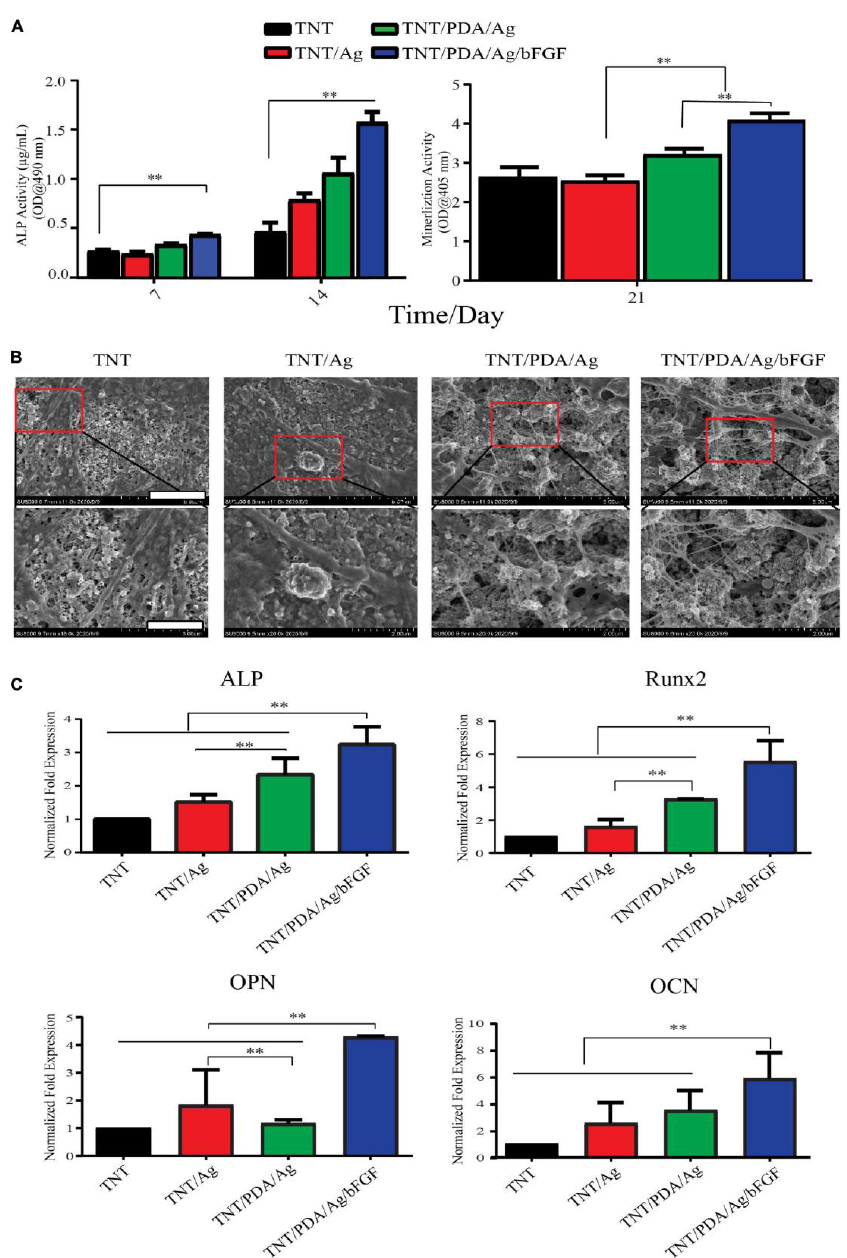
Figure 9. Growth factor-releasing nanotubular implants towards osseointegration. Enhanced osteogenic differentiation of dental pulp stem cells (DPSCs) on bFGF-loaded TNTs. ( A ) DPSCs showed significantly higher alkaline phosphate (ALP) activity; ( A , B ) more calcium deposition on bFGF-loaded TNTs, detected by Alizarin red staining ( A ) and SEM observation ( B ). ( C ) Significantly higher expression of ALP, Runx2, osteopontin (OPN), and osteocalcin (OCN) from DPSCs. ** p < 0.01. Reproduced with permission from [120].